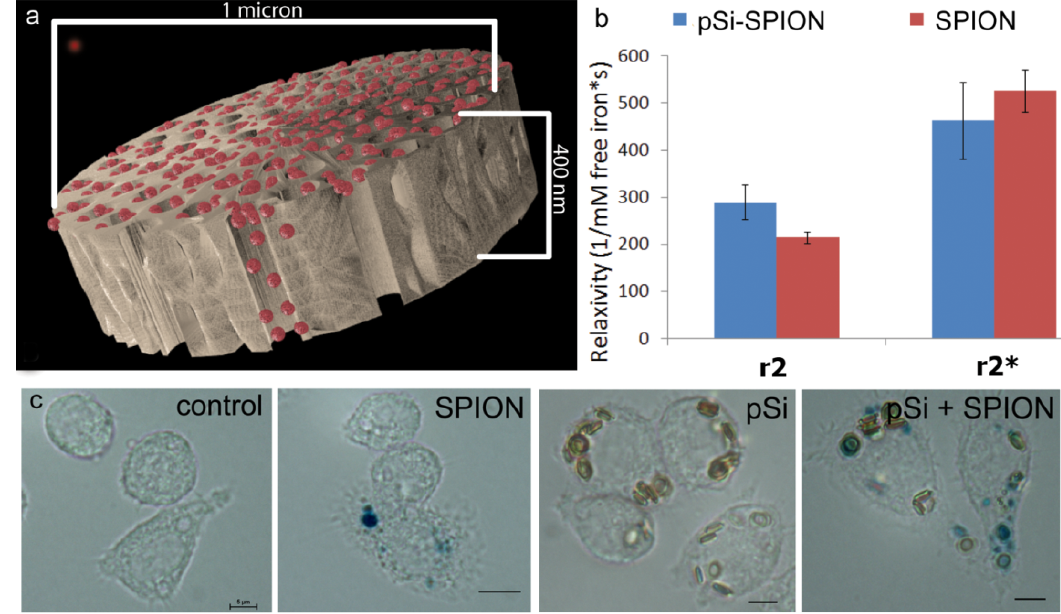
Figure 3. Influence of SPION encapsulation in the pores of pSi microparticles on MRI contrast enhancement and cellular uptake. ( a ) Computer simulated image showing SPIONs (red) loaded into a discoidal pSi microparticle; ( b ) r and r * relaxivity of free or 2 2 encapsulated 30 nm SPIONs in agarose phantoms. Relaxivity was calculated using the slope of the relaxation rate vs. concentration. Error bars represent 95% confidence intervals; ( c ) Bright field micrographs of J774 mouse macrophages following 24 h incubation with free (SPION) or pSi encapsulated SPIONs (pSi + SPION), or unloaded pSi microparticles (pSi). Cells were stained with Prussian blue to visualize localization of iron